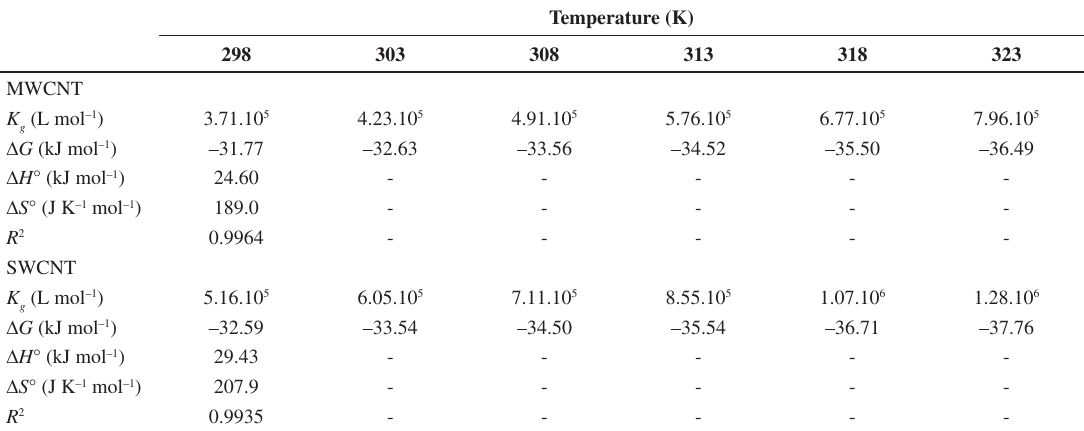
Table 4. Thermodynamic parameters of the adsorption of RB-4 dye on MWCNT and SWCNT adsorbents. Conditions: adsorbent mass 30.0 mg, pH fixed at 2.0; contact time of 4